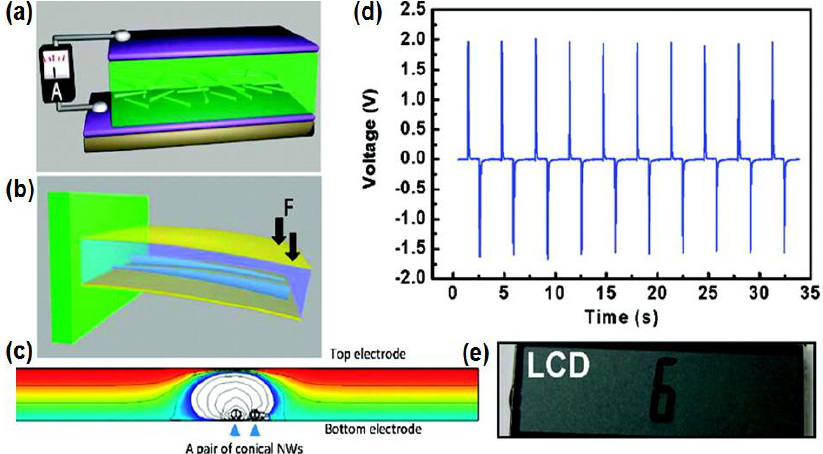
Figure 8. ( a ) A schematic image of the fabricated energy harvester using ZnO conical nanowires (CNWs) and ( b ) a model showing the setup for measuring the energy conversion. The polystyrene substrate used to hold the nanogenerator at its upper side, where the force, F, is applied. The CNWs are under compressive strain during the deformation; ( c ) the model used for calculating the potential distribution across the top and bottom electrodes of the harvester with the presence of a pair of CNWs; ( d ) the measured output voltage; ( e ) a snap shot of an LC display driven by the harvester. Reprinted with permission from [45]. Copyright 2010, American Chemical